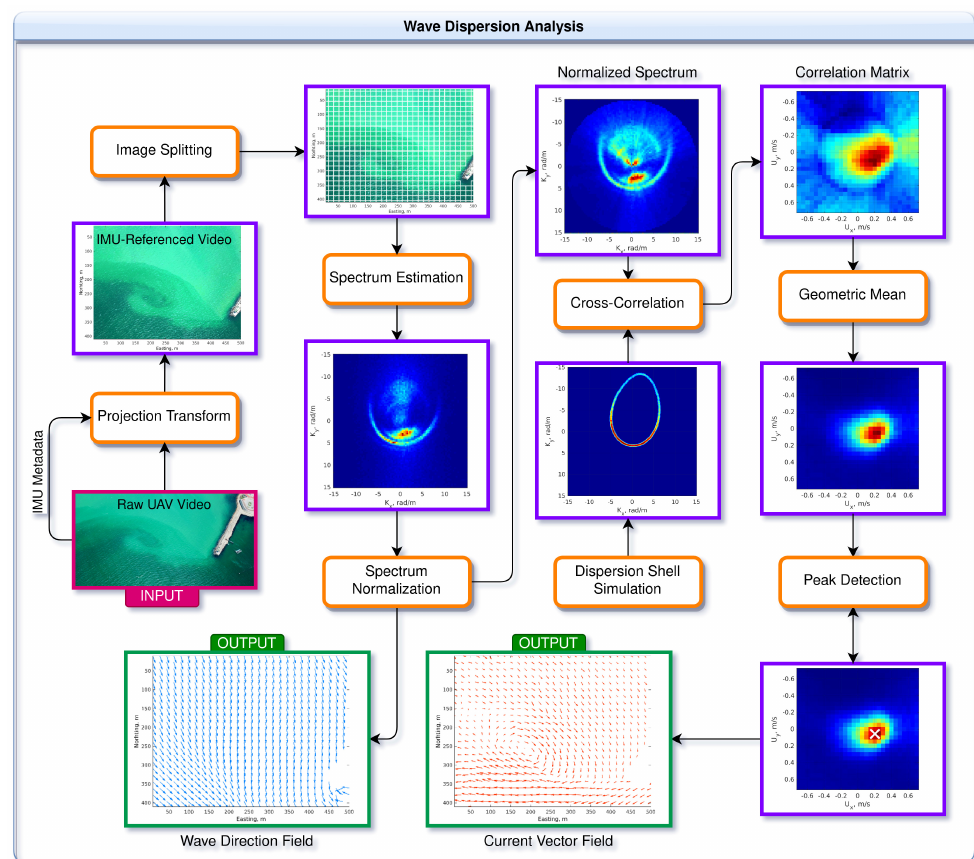
Figure 2. Flowchart diagram showing the Wave Dispersion Analysis (WDA) method of the sea surface current (SSC)